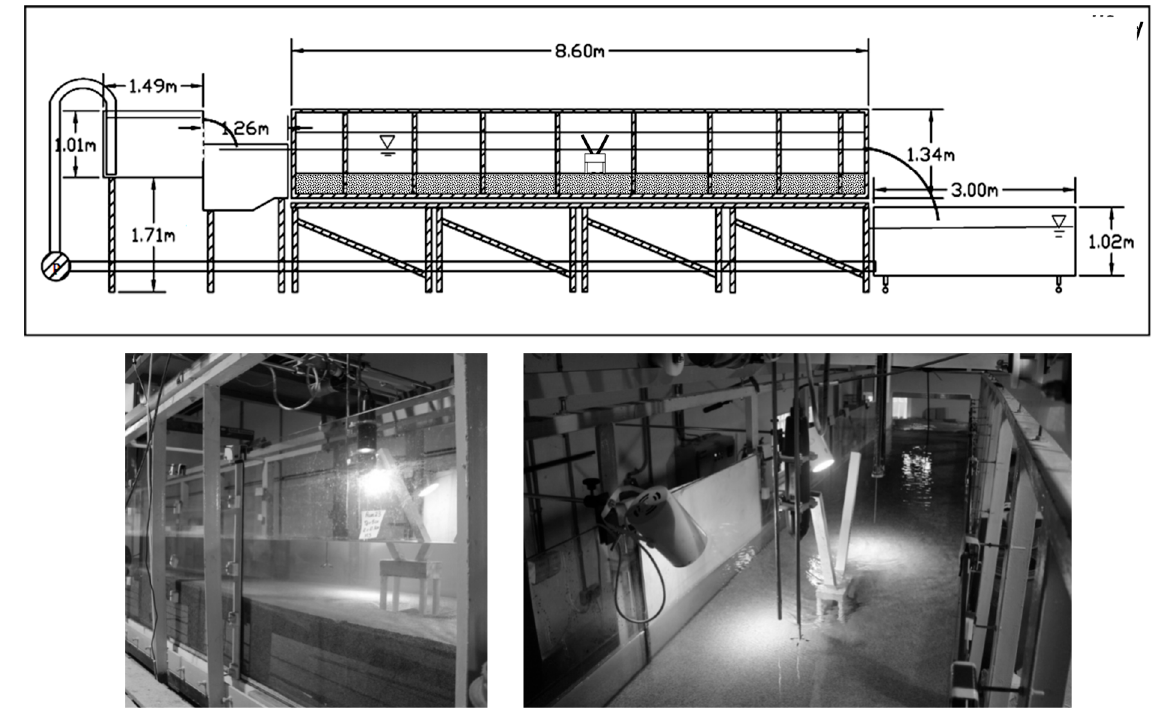
Figure 4. Scheme and sample photograph of the experimental flume.